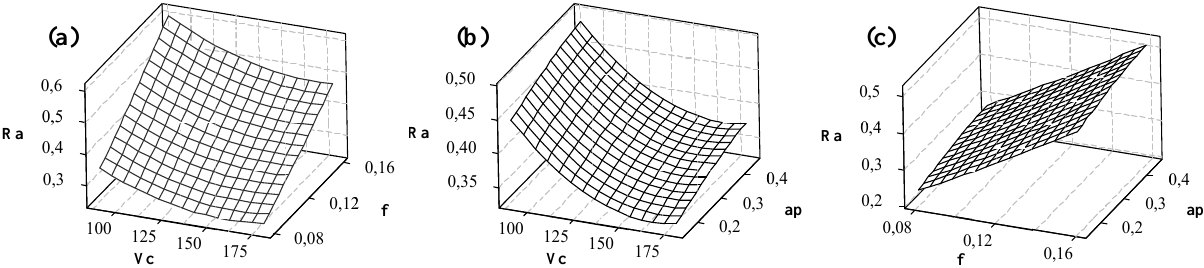
Fig.2. (a) 3D surface plots for interaction effects of feed rate and cutting speed, (b) depth of